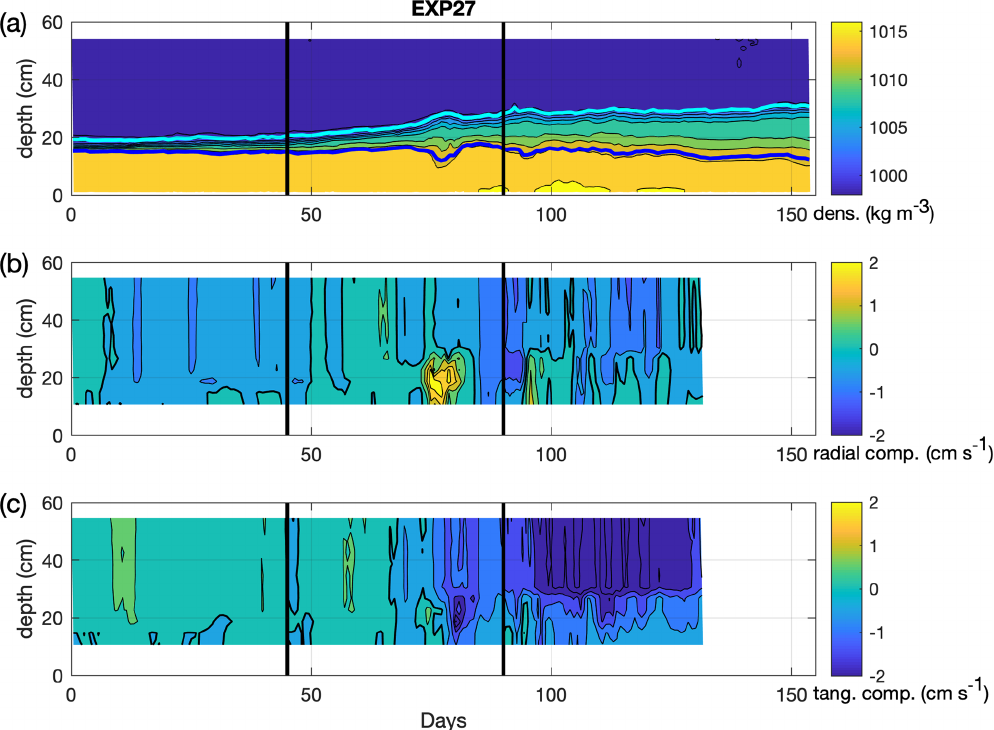
Figure B1. Hovmöller diagram of density (a) as well as radial (b) and tangential (c) velocity components for EXP 27. The black isoline interval in panel (a) is 2kgm − 3 , starting from 1016kgm − 3 at the bottom; thick cyan and blue lines denote MLD and the base of the pycnocline, respectively. Bold isolines in panels (b) and (c) indicate 0cms − 1 , and the isoline interval is 0.5cms − 1 . Black solid vertical lines indicate rotation days 45 and 90, i.e., the start and end of the high-density water injection, respectively (for reference, see Fig. 2 and Tables 1 and 2) “Days” stand for rotation